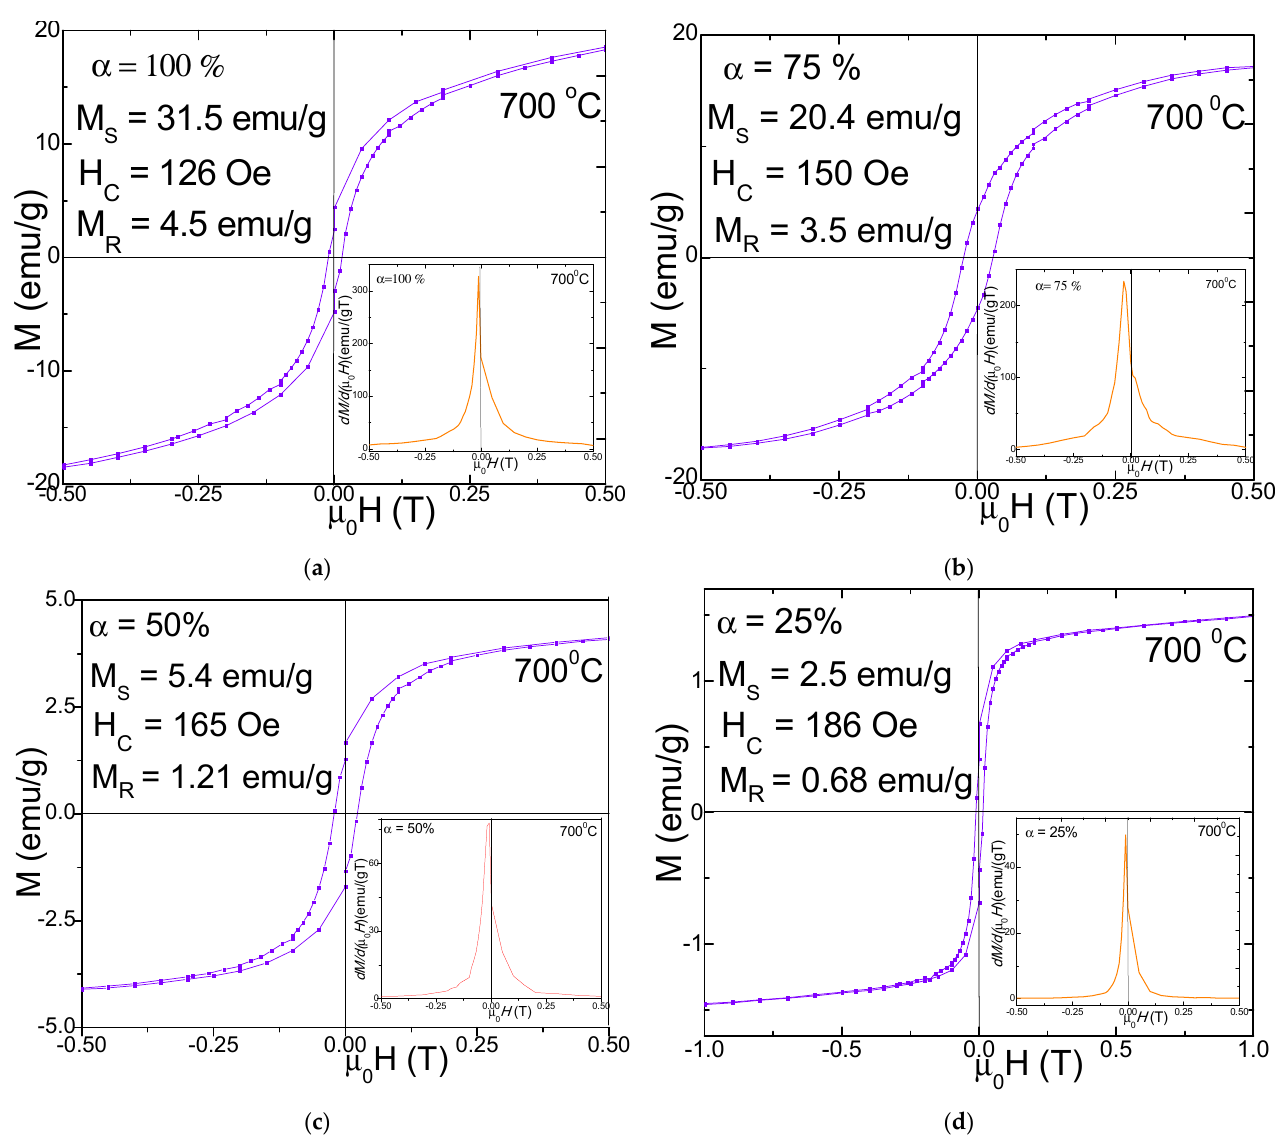
Figure 4. Magnetic hysteresis loop and magnetization derivative of (N i0 . 6 Mn 0.4 Fe 2 O 4 ) α (SiO 2 ) 100 − α ( α = 100% ( a ), 75% ( b ), 50% ( c ) and 25% ( d )) NCs calcined at 700 ◦